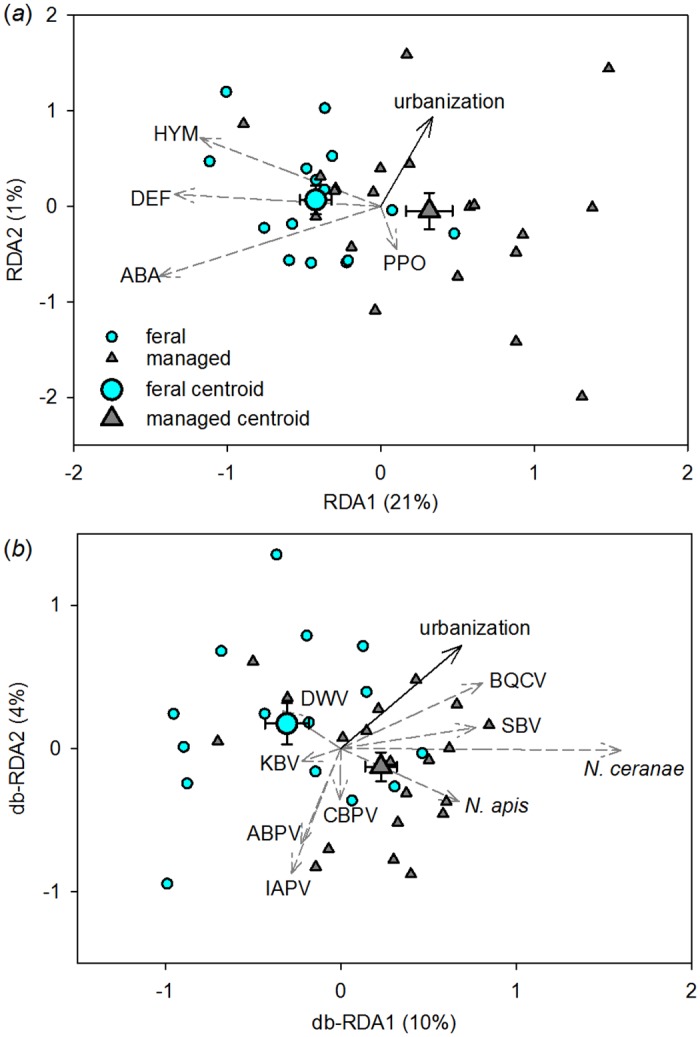
Ordination of immune protein transcripts (A) and disease transcripts (B) in response to urbanization and management.Arrows indicate the direction of increase of continuous variables in multivariate space; solid black arrows are predictors and dashed gray arrows are responses. The wider the angle between a pair of arrows, the less correlated the variables they represent. Each small symbol represents one colony, with distances between symbols approximating dissimilarity in immune transcript composition (A) or disease composition (B) among colonies. Centroids represent the categorical effect of management as the mean responses of feral and managed colonies ± SEM. Immune transcript abbreviations: ABA, abaecin; DEF, defensin; HYM, hymenoptaecin; PPO, prophenoloxidase. Disease abbreviations: ABPV, Acute Bee Paralysis Virus; BQCV, Black Queen Cell Virus; CBPV, Chronic Bee Paralysis Virus; DWV, Deformed Wing Virus; IAPV, Israeli Acute Paralysis Virus; KBV, Kashmir Bee Virus; SBV, Sac Brood Virus.